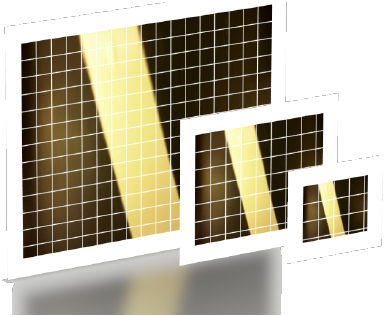
Figure 8. An example of the Gaussian Pyramid downsampling. The higher resolution is the first level, and each new level is half of the previous